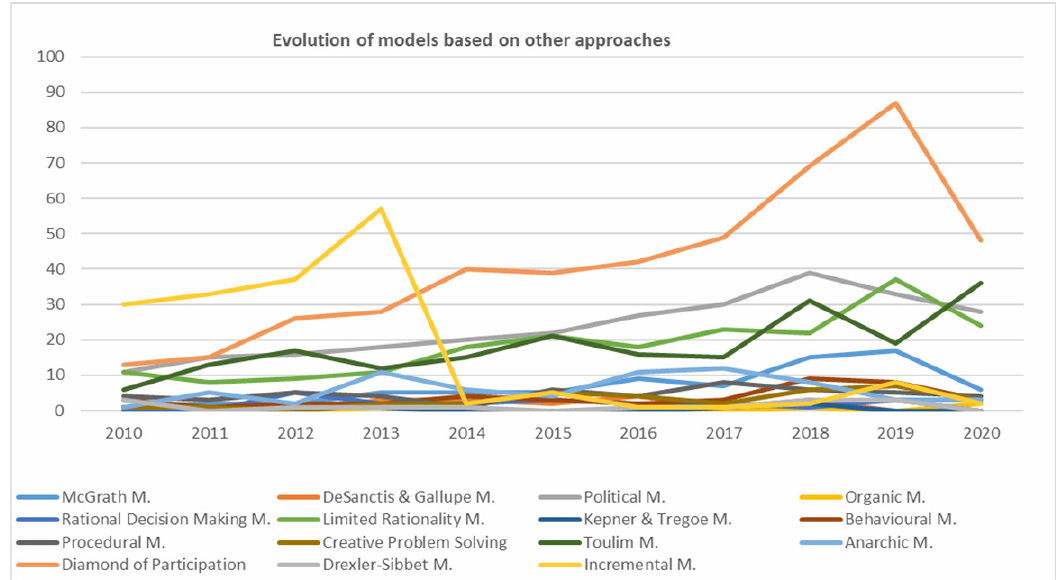
Figure 6. Evolution of other approaches.